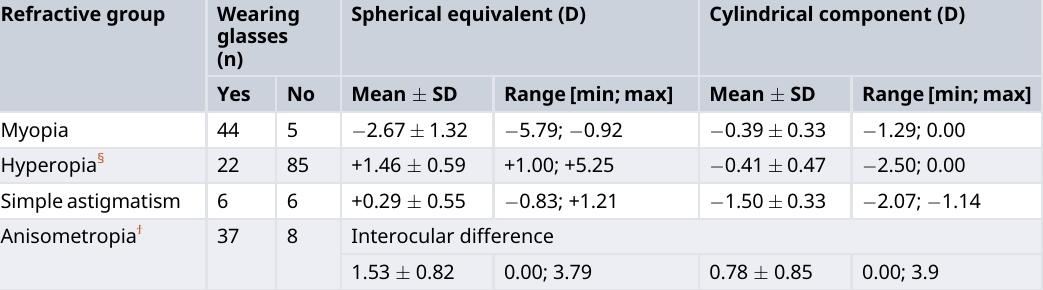
Table 3. Mean values and standard deviation of refractive errors of subjects with significant ametropia (right eye